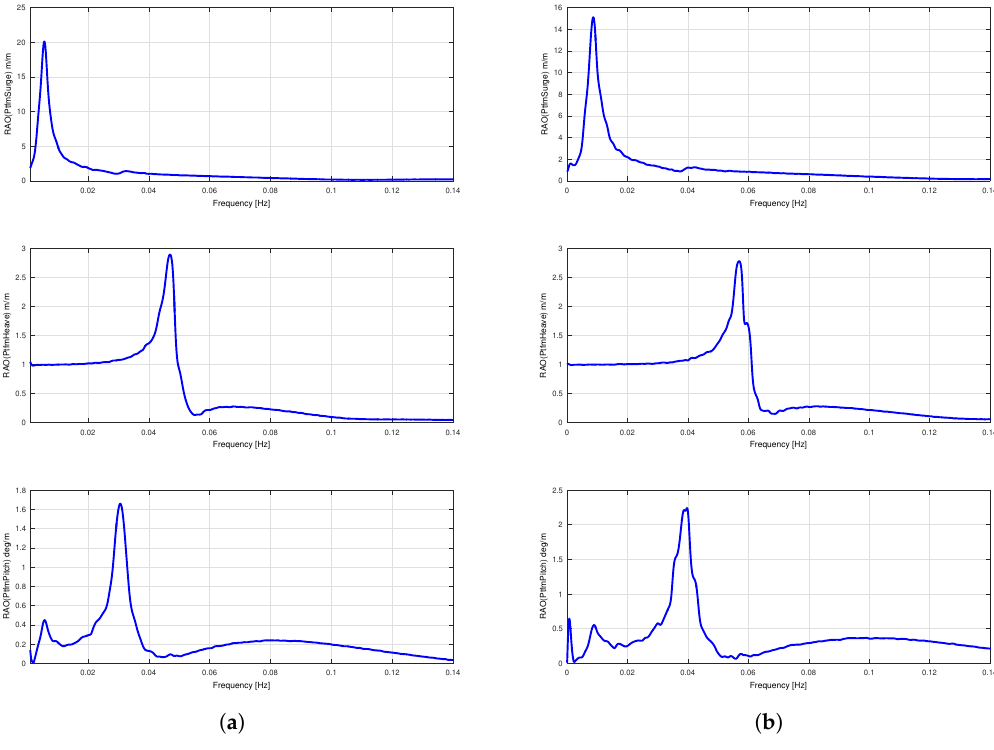
Figure 13. RAOs under zero wind speed: ( a ) for the SNL 13.2 MW model; ( b ) for the OC4 DeepCwind